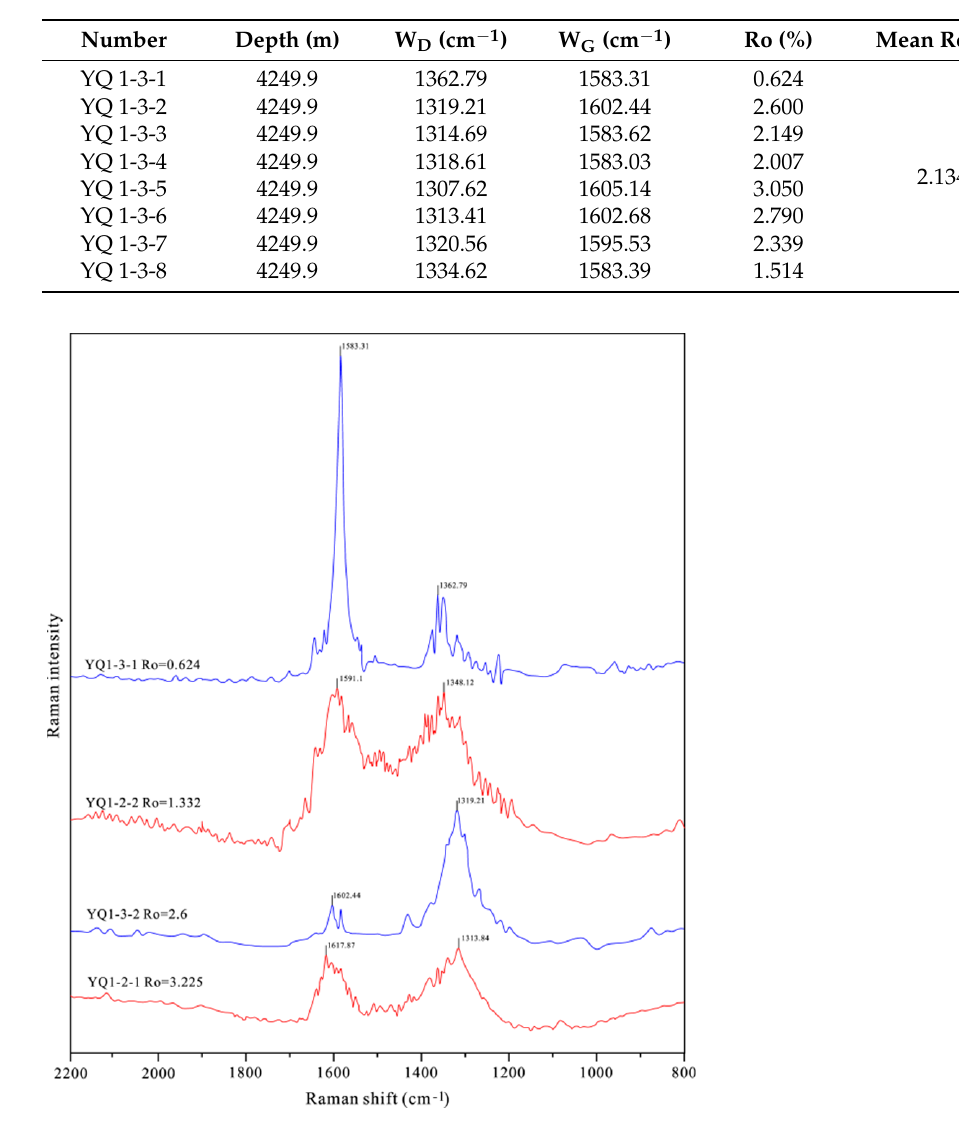
Table 2. Laser Raman results of reservoir bitumen.